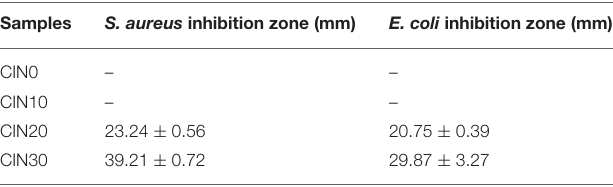
TABLE 2 | The inhibition zones of grasshopper protein (GP)-based composite films against Staphylococcus aureus and Escherichia coli .